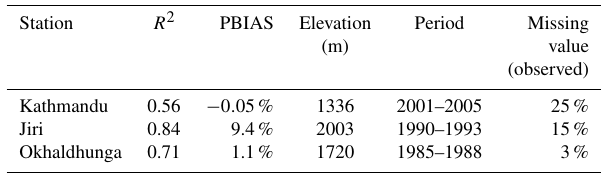
Table 1. Goodness-of-fit statistics of PET simulation results for dif- ferent stations.